Question: Write a single sentence explaining what this figure depicts.
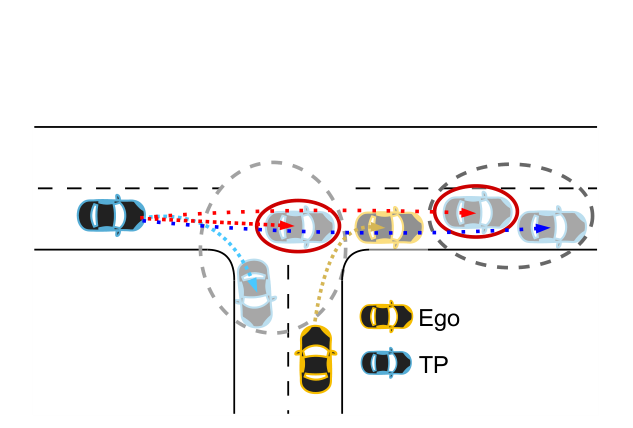
Answer: Illustration of the Scenario Selection procedure. Predictions enclosed in grey ellipses belong to same cluster. Red ellipses mark scenarios selected from each cluster.